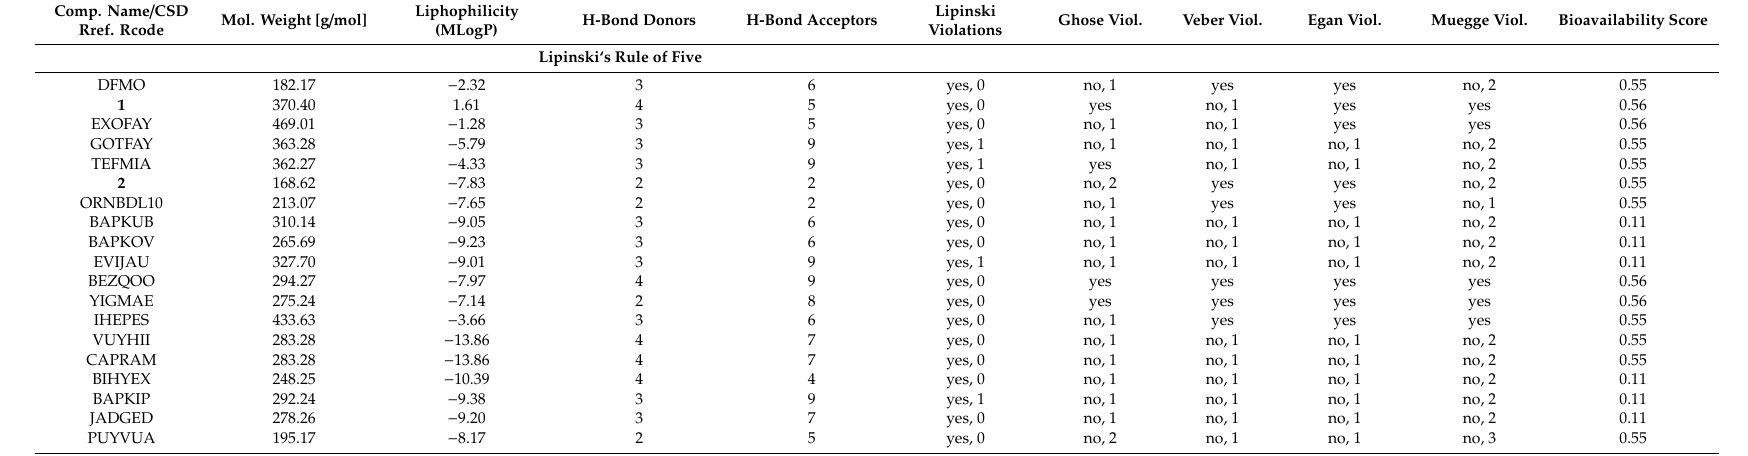
Table 5. Drug-likeness predictions of the analyzed